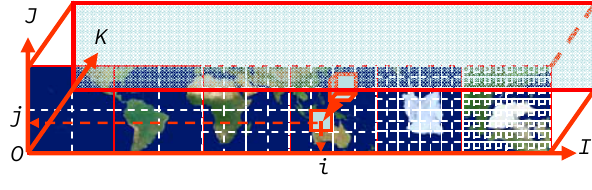
Figure 13. The e-Octree coding